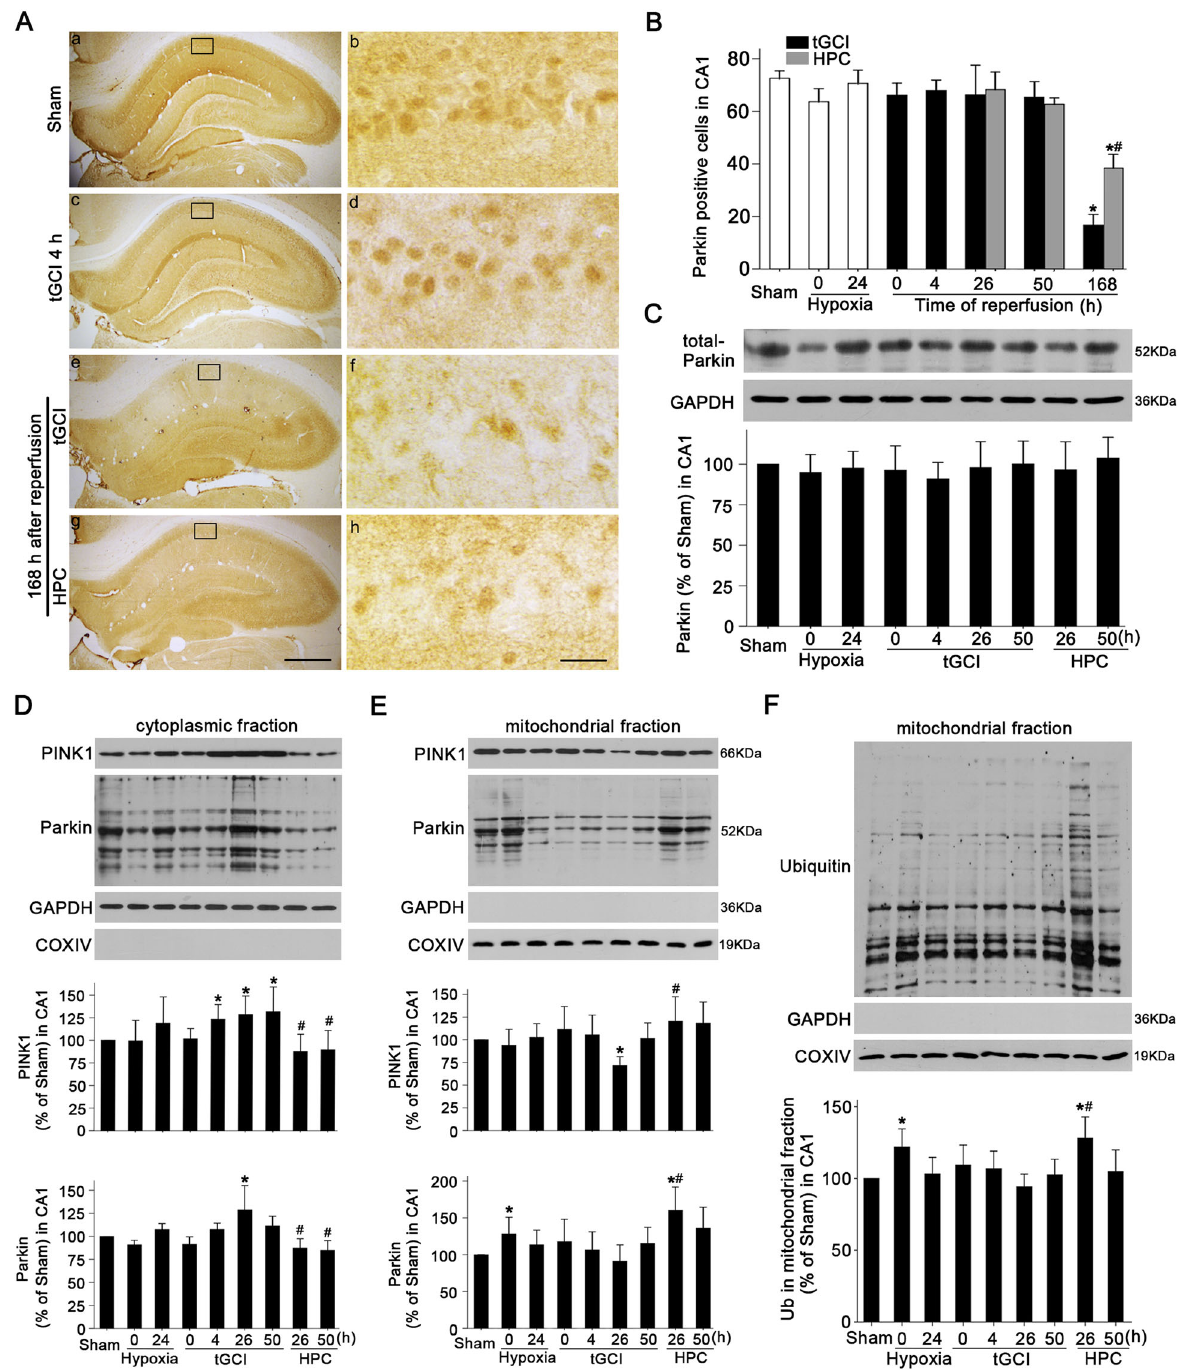
Fig. 4 Effects of HPC on the expression of Parkin and the activation of PINK1/Parkin pathway in CA1 after tGCI. A Immunohistochemistry of Parkin in the rat brains. Representative images show Sham group (a and b), 4 h after reperfusion of tGCI groups (c and d), 168 h after reperfusion of tGCI groups (e and f) and 168 h after reperfusion of HPC groups (g and h), respectively. Scale bar: a, c, e, g: 250 μ m; b, d, f, h: 25 μ m. B Quantitative analysis of Parkin-positive cells in CA1 ( n = 6 in each group). C Western blot analysis of Parkin in CA1. The histogram presents the quantitative analyses of Parkin levels ( n = 4 in each group). Western blot analysis of PINK1 and Parkin in the cytoplasmic fraction ( D ) and mitochondrial fraction ( E ) of CA1. The histogram presents the quantitative analyses of PINK1 and Parkin levels ( n ≥ 4 in each group). F Western blot analysis of ubiquitin in the mitochondrial fraction of CA1. The histogram presents the quantitative analyses of ubiquitin levels ( n ≥ 4 in each group). Data are expressed as percentage of value of Sham animals. Each bar represents the mean ± SD. * p < 0.05 vs. Sham group, # p < 0.05 vs. tGCI group at the same time